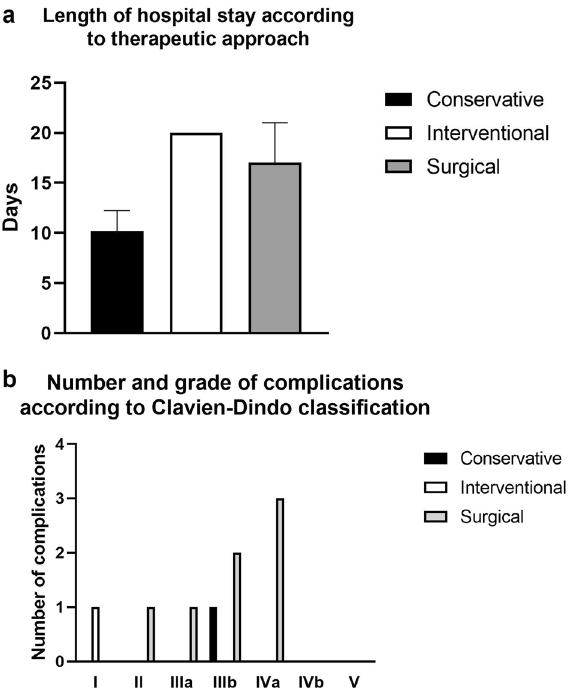
Figure 3. ( a ) Length of stay in days according to type of therapy. ( b ) Distribution and number of adverse events according to Clavien-Dindo classification of postoperative